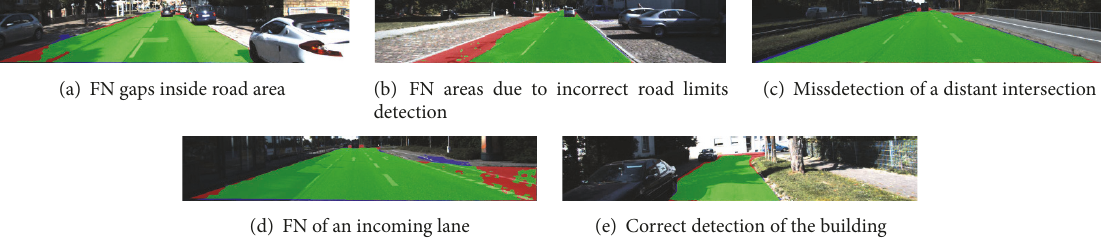
Figure 9: Results from the perspective-trained model.